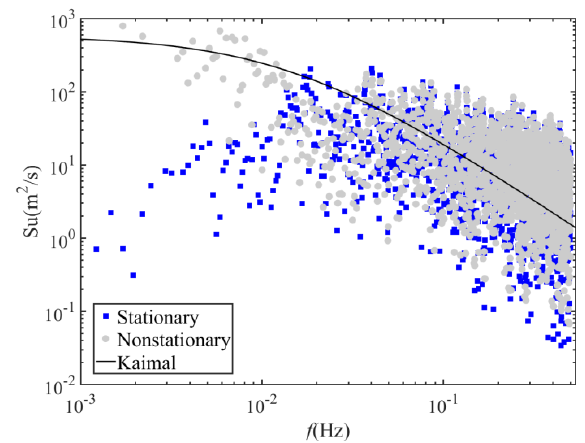
Figure 10. Comparison of the measured longitudinal spectra of Typhoon Lekima and the Kaimal spectrum.